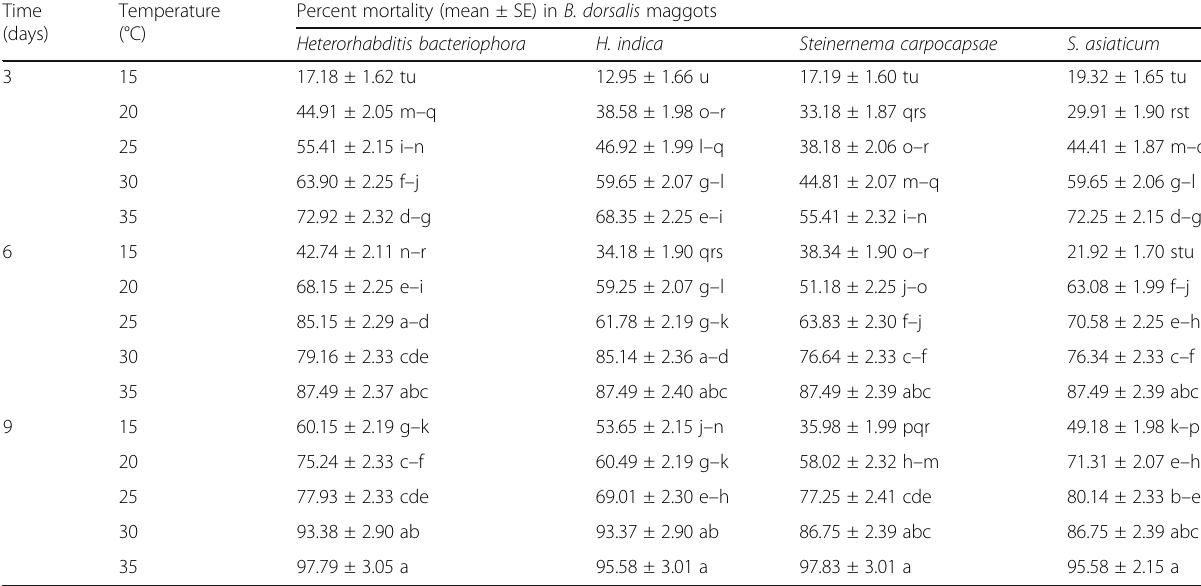
Table 1 Corrected percent mortality (mean ± SE) in Bactrocera dorsalis maggots (3rd instar) exposed to different EPNs at different temperature degrees and time periods (DF = 24, F = 6.20, P = 0.00) Time Temperature Percent mortality (mean ± SE) in B. dorsalis maggots (days) (°C) Heterorhabditis